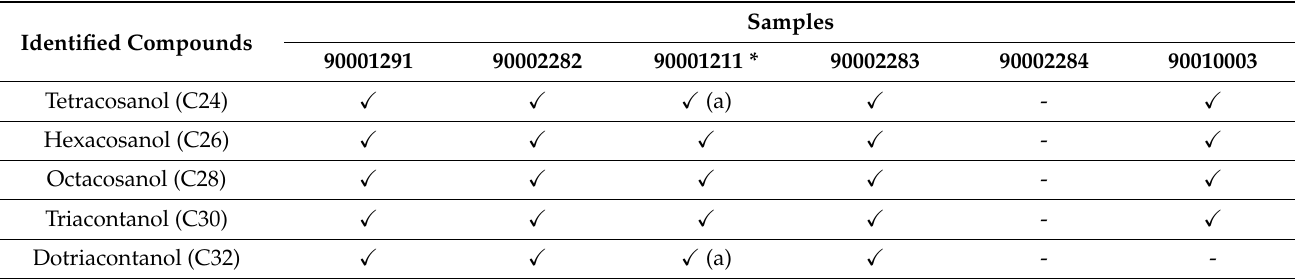
Table 4. List of identified fatty alcohols obtained from saponification of embalming substances from gazelle